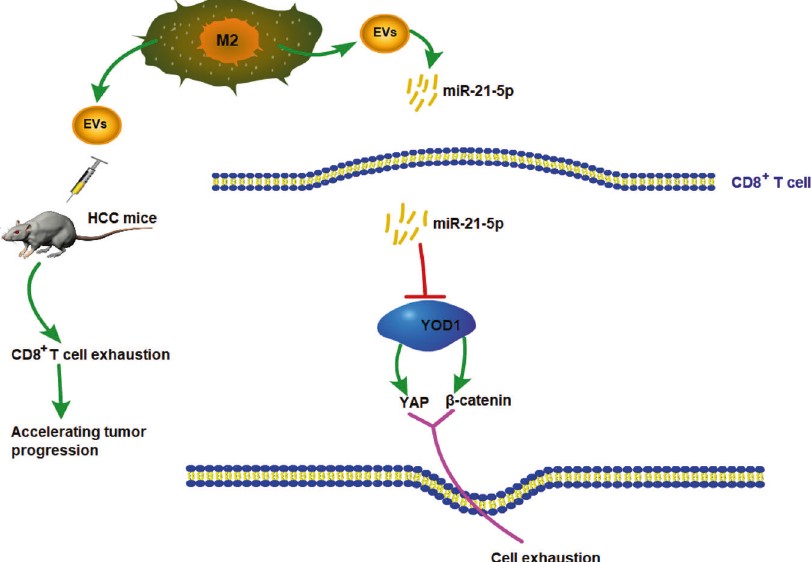
Fig. 8 M2 macrophage-derived EVs promote the depletion of CD8 + T cells in HCC via the miR-21-5p/YOD1/YAP/ β -catenin axis. M2 macrophage-derived EVs carried miR-21-5p into CD8 + T cells, inhibited YOD1 expression, and activated the YAP/ β -catenin pathway, thereby promoting CD8 + T cell exhaustion in HCC.